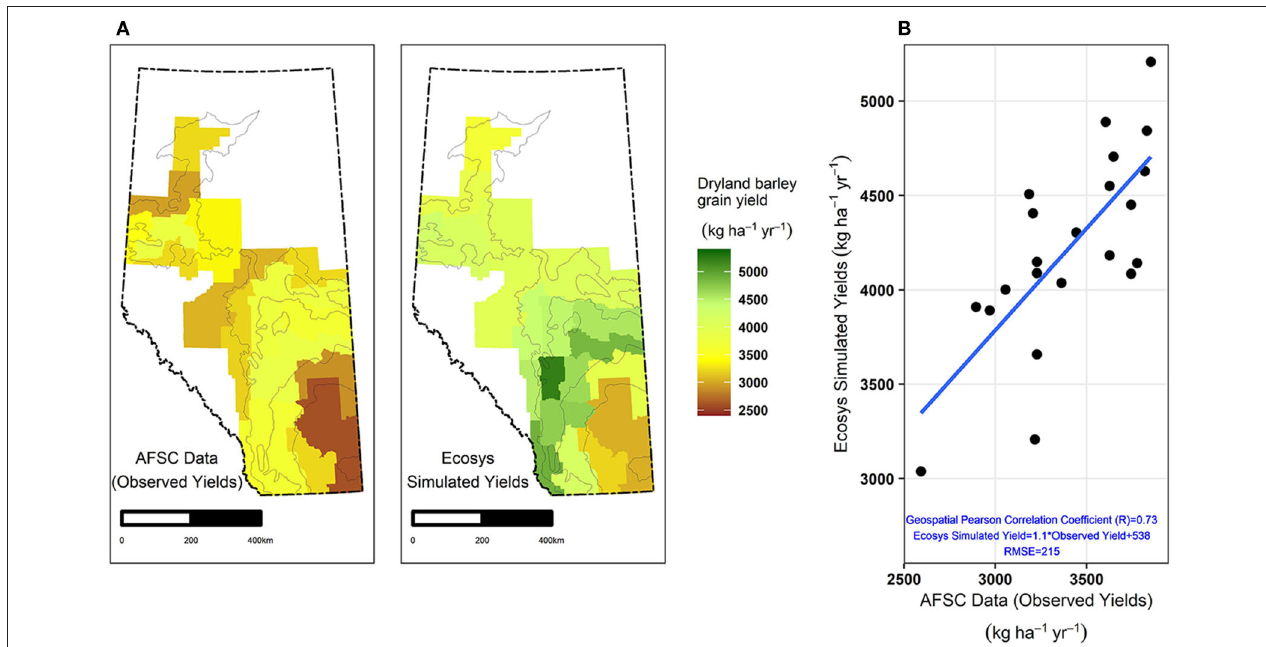
FIGURE 6 | (A) Spatial distribution of observed and modeled dryland or rainfed barley grain yields across Alberta’s agricultural areas averaged over the simulation period (2011–2015). Modeled barley grain yields were simulated only for mid-slope landforms. Observed grain yields were averaged (area-weighted) for fields across all landforms as compiled and published by Alberta Financial Services Corporation (AFSC) based on farmers’ reported yields (AFSC, 2019). Both the simulated and observed yields were averaged to each of the 22 AFSC designated risk areas (AFSC, 2019). The white areas on the map were not modeled based on the selection criteria as described in section Methodology and Model Inputs. The thick dashed lines on the maps represent Alberta’s provincial boundary and the thin black lines within the maps demarcate soil group areas. (B) Relationship between simulated and observed yields (AFSC data) averaged over the simulation period (2011–2015) for each of the AFSC risk areas. RMSE, root mean square for errors in kg ha − 1 year − 1